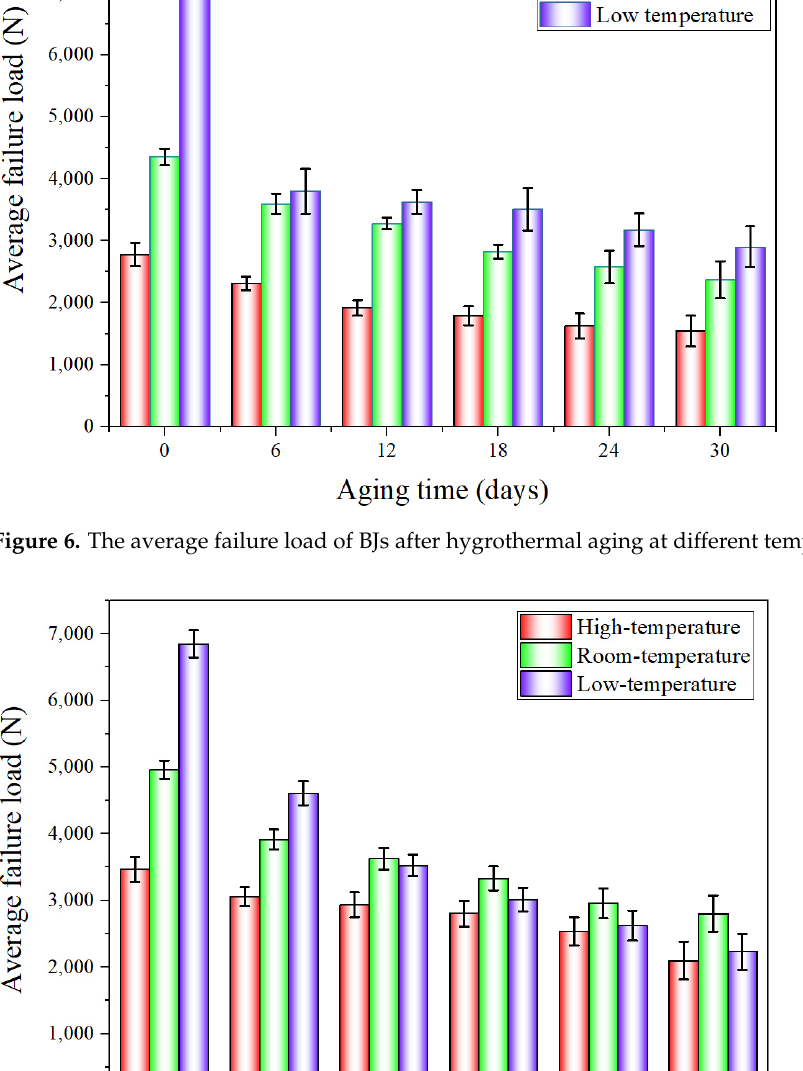
Figure 5. Quasi-static mechanical properties test at different temperatures.